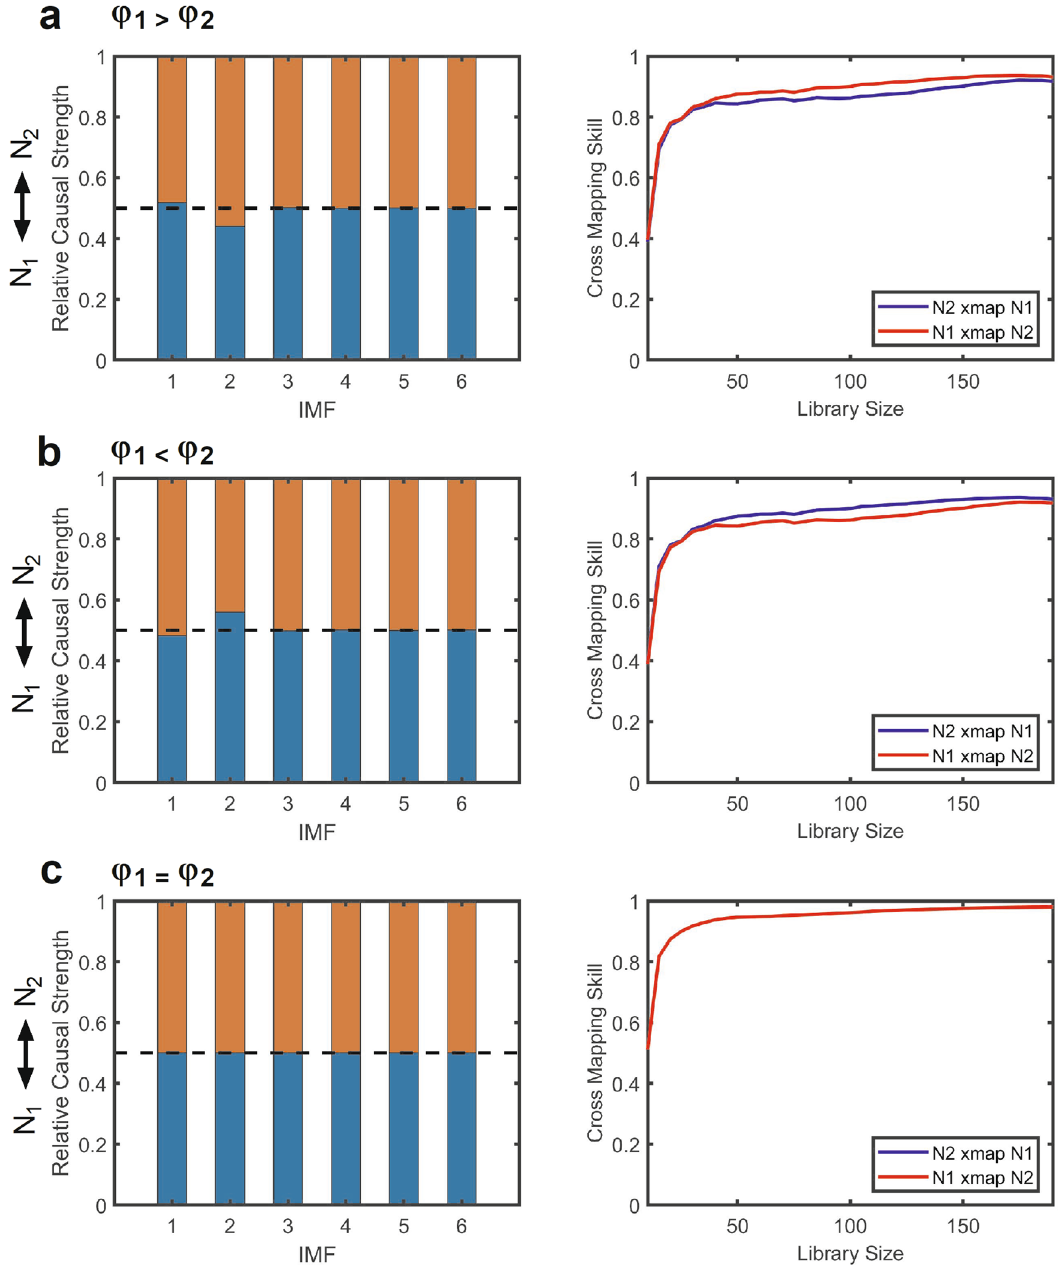
Fig. 1 Causal patterns of adult-recruitment model in various settings of environmental forcing. The adult-recruitment model is a 5-variate differential equation to simulate the Moran effect that the populations of two independent species N 1 and N 2 are driven by the external forcing of the environmental noise. With appropriate mathematical deductions (see supplementary information), we found that N 1 and N 2 are causally coupled with each other and the causal strengths between them are driven by the ratio of environmental forcing. For simplicity, the parameters were given here as r 1 = 3.4, s 1 = 0.4, and D = 3, as well as r = 3.4, s = 0.4, and D = 3. The initial value of R and N was set as 1 and 0.5, respectively in both pairs. The model was simulated for 1 2 2 2 10,000 iterations and the last 200 data points of N 1 and N 2 were extracted for causal analysis with causal decomposition and convergent cross mapping (CCM) method. The parameters for causal decomposition and CCM method were the same with Chang et al 1 . (i.e., noise level = 0.085, ensemble number = 1000, and embedding dimension for CCM = 4). We tested the causal decomposition and CCM results in the various settings of environmental forcing at ( a ), φ 1 = 0.6 and φ 2 = 0.5; ( b ), φ 1 = 0.5 and φ 2 = 0.6; and ( c ), φ 1 = 0.5 and φ 2 = 0.5. As expected, the causal decomposition showed a correct direction of coupling in these different settings of environmental forcing. CCM also showed a consistent pattern of bi-directional coupling between N 1 and N 2 in three settings (statistical tests of Kendall ’ s τ test and Fisher ’ s Δρ Z score for the signi fi cance of convergence of cross mapping showed p < 0.05 in all